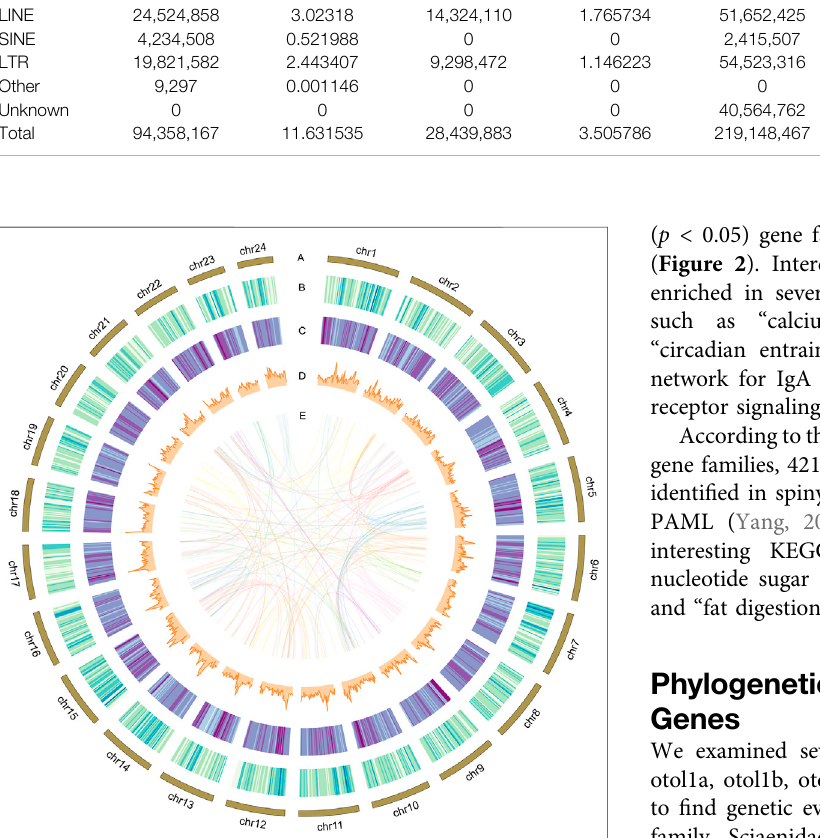
FIGURE 1 | Characterization of the assembled genome for spiny head croaker. From outside to inside: (A) chromosomes of spiny head croaker; (B) genedensityofthegenome; (C) repeatdensityofthegenome; (D) GCcontent of the genome; (E) paralogous genes on different chromosomes. (B – D) were drawn in 500-kb sliding windows.